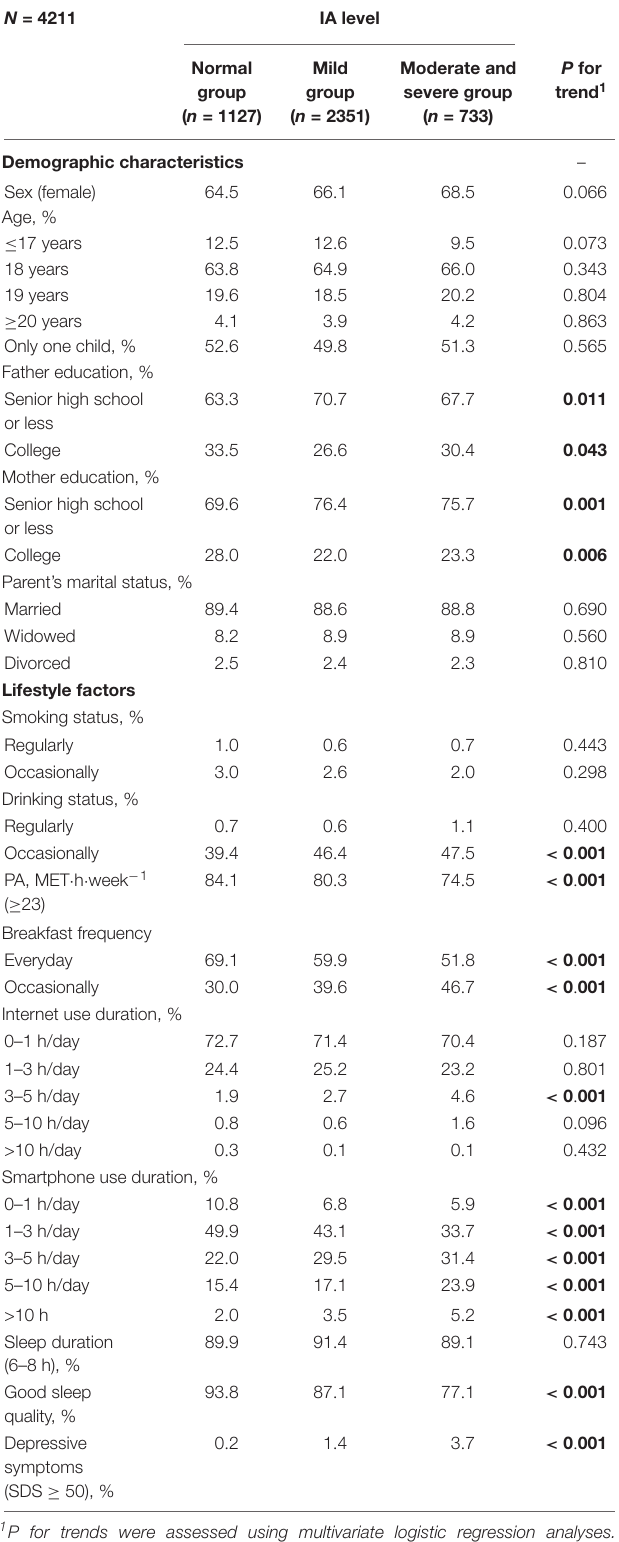
TABLE 1 | Sex- and age-adjusted participants’ characteristics according to IA